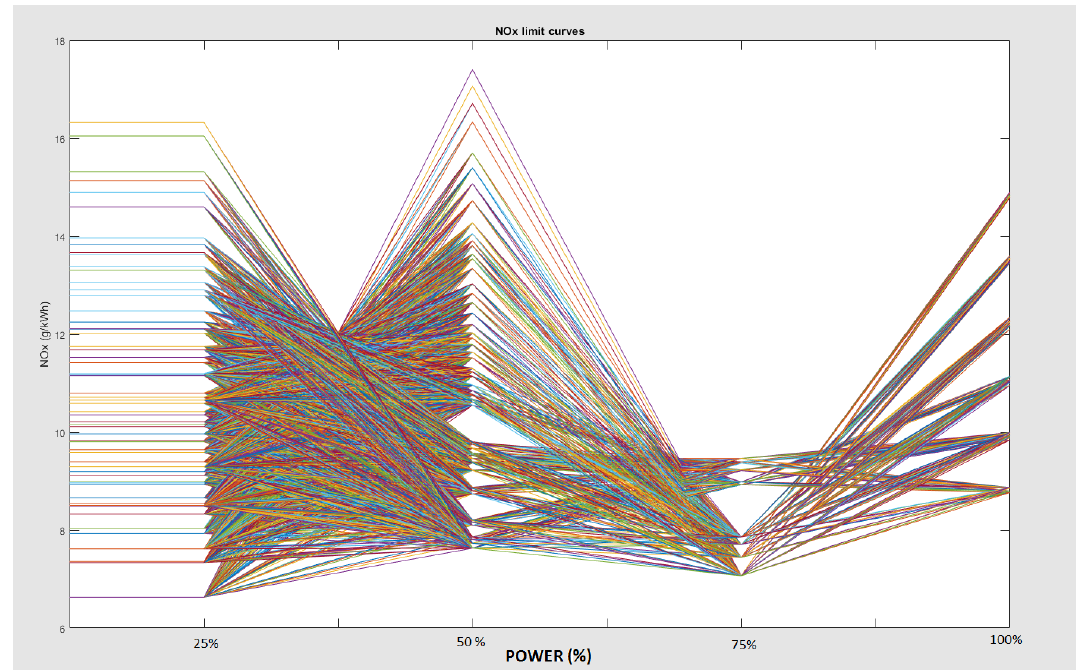
Figure 5. Examplary of eligible NO x